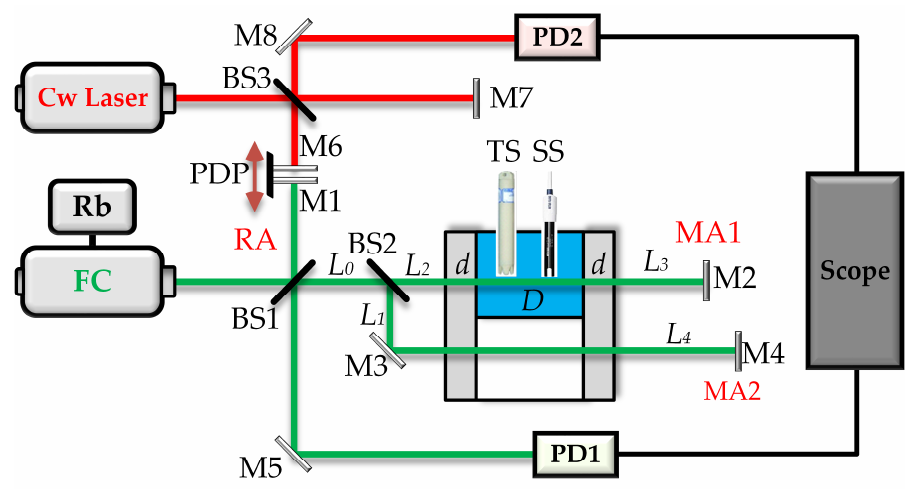
Figure 1. Temperature and salinity measurement experiment setup. FC: Frequency Comb; Rb: